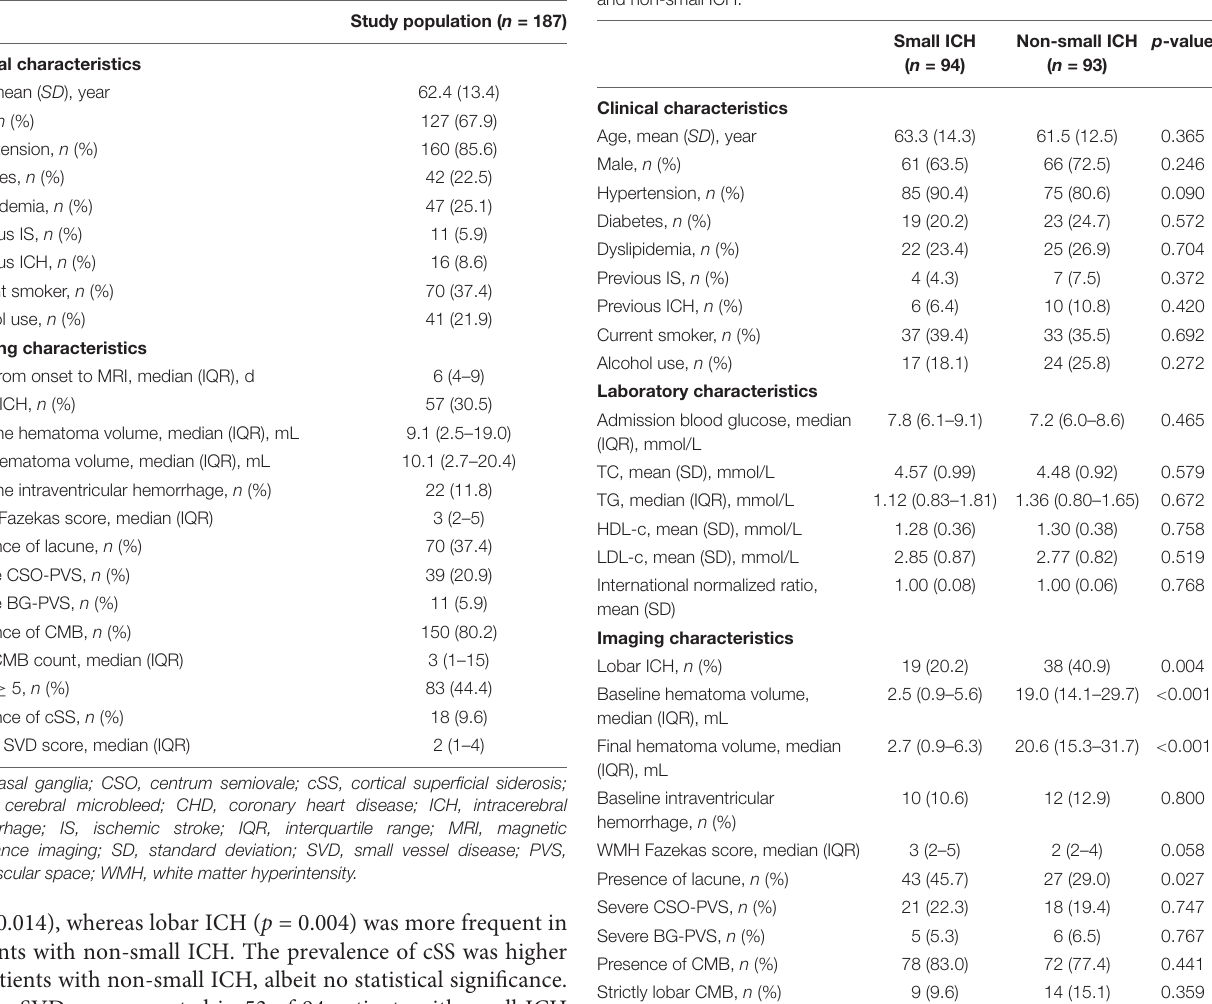
TABLE 1 | Baseline clinical and imaging characteristics of the study population.